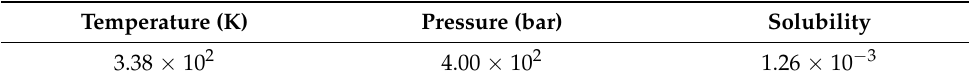
Figure 7. Trends for Pressure (bar). Table 3. Optimized amount of inputs and